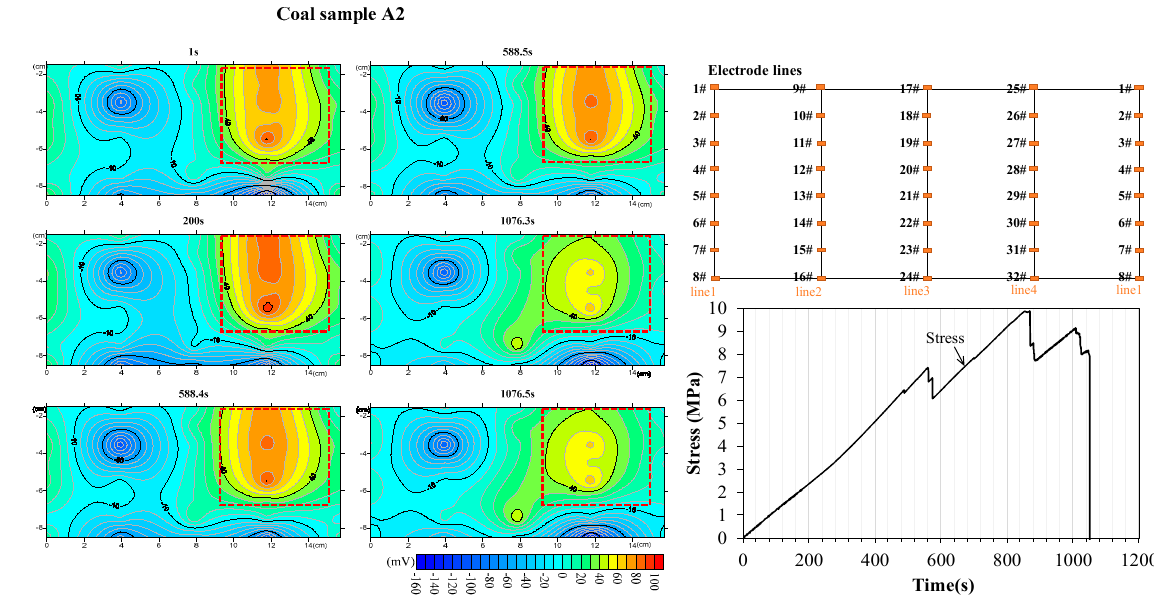
Figure 9. Profiles of the variation in self-potential with time for coal sample A2. Areas of significant change in self-potential are indicated by red dashed lines. 1#–32# stand for the electrode 1 to electrode 32.